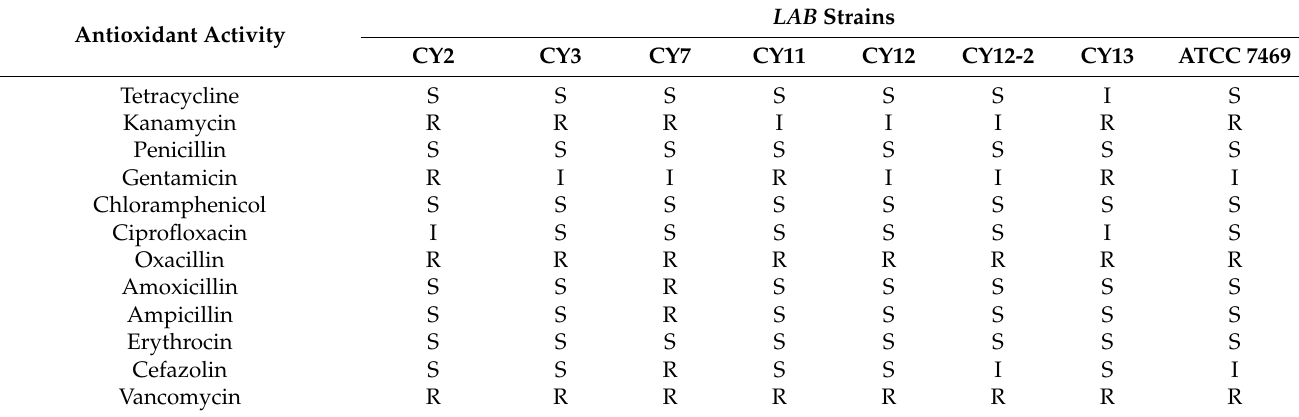
Table 6. Antibiotic resistances of the Lactobacillus